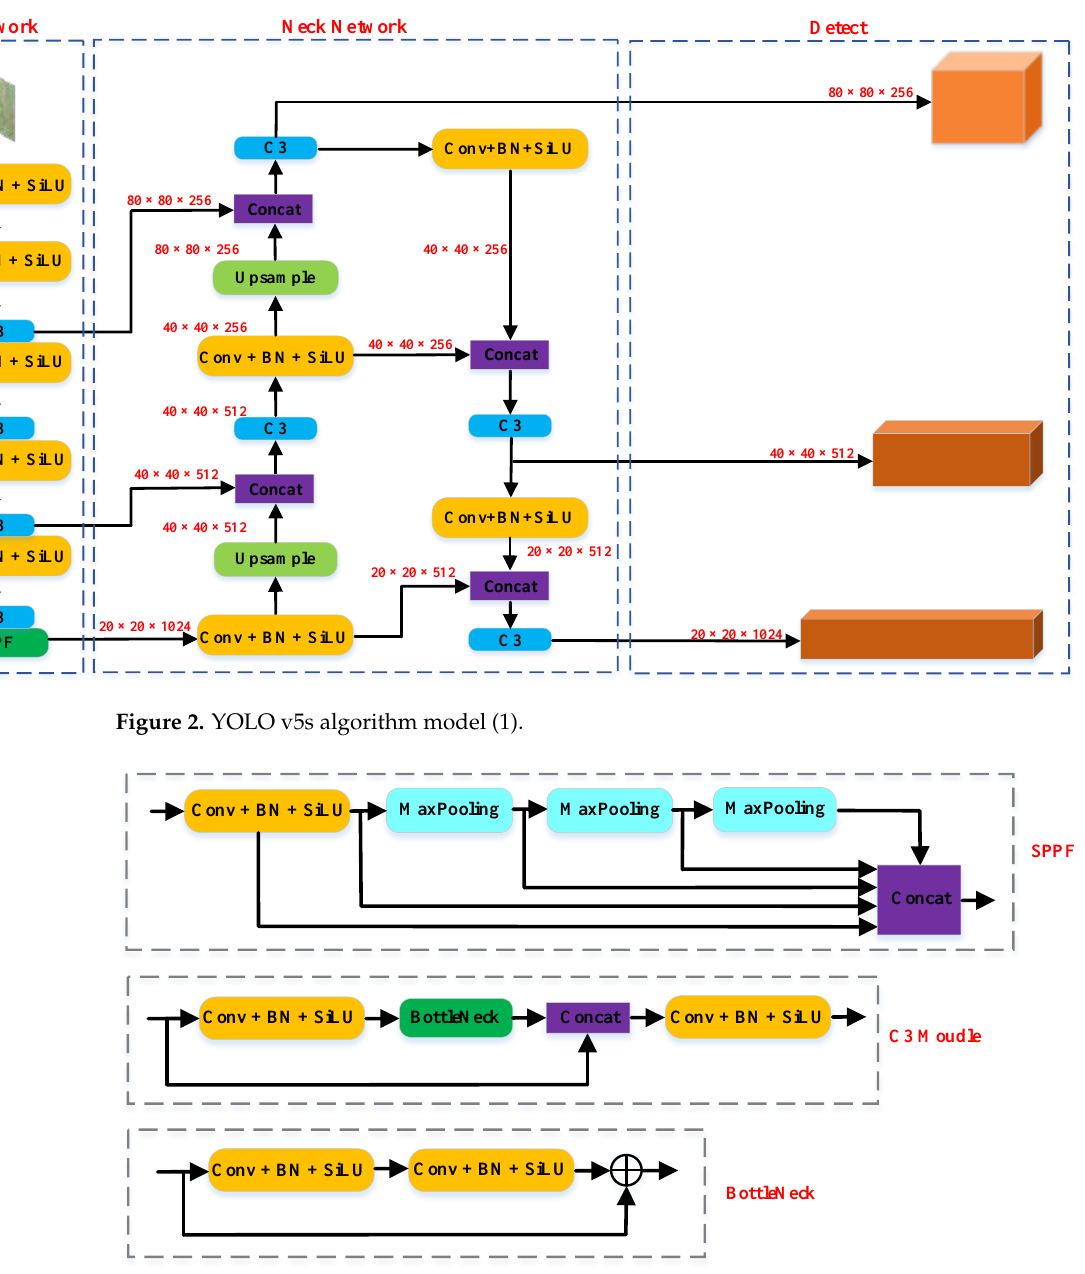
Figure 3. YOLO v5s algorithm model (2).